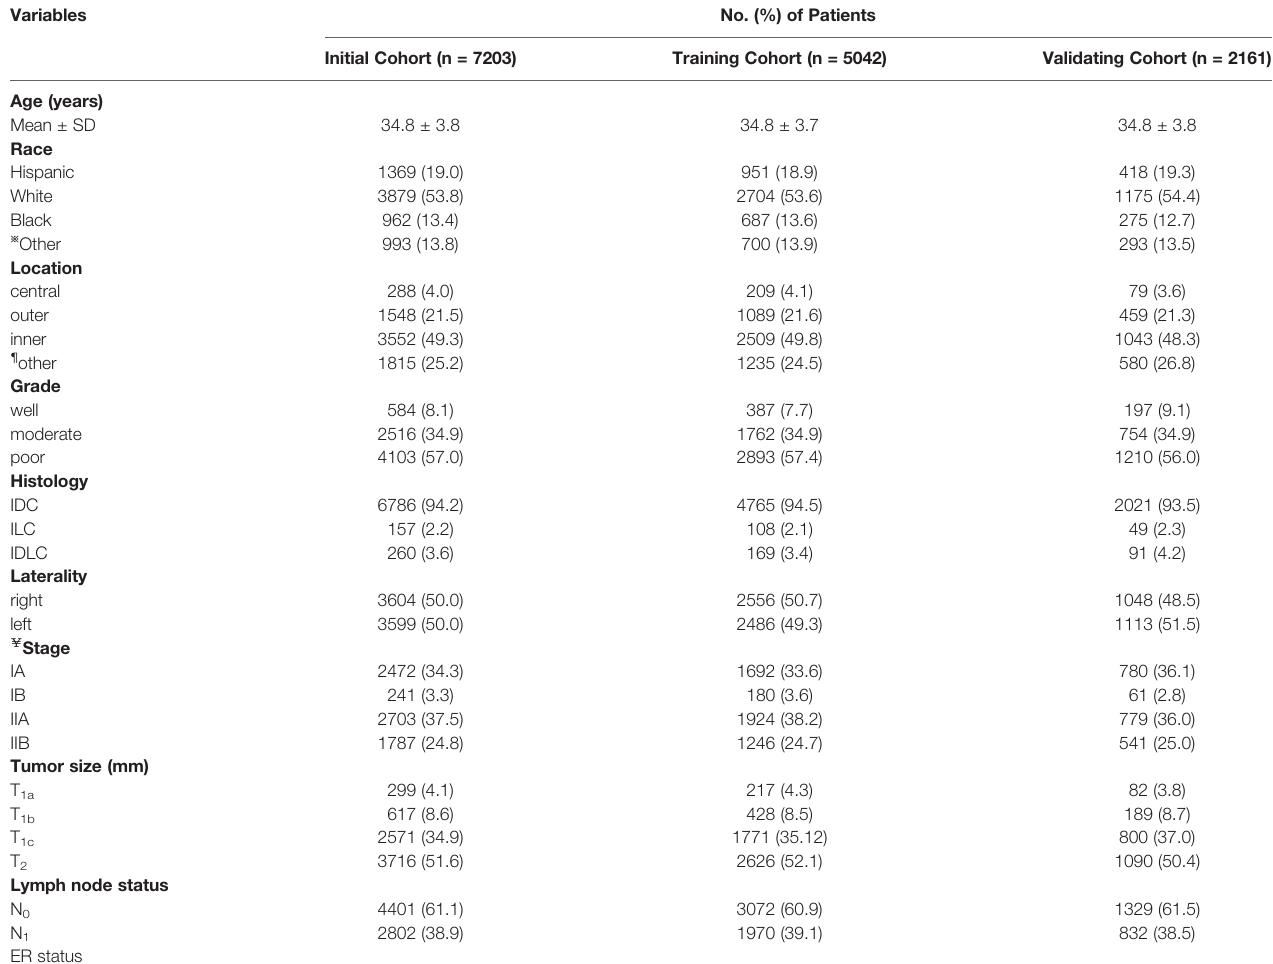
TABLE 1 | Clinicopathological characteristics of young women with early-stage breast cancer.